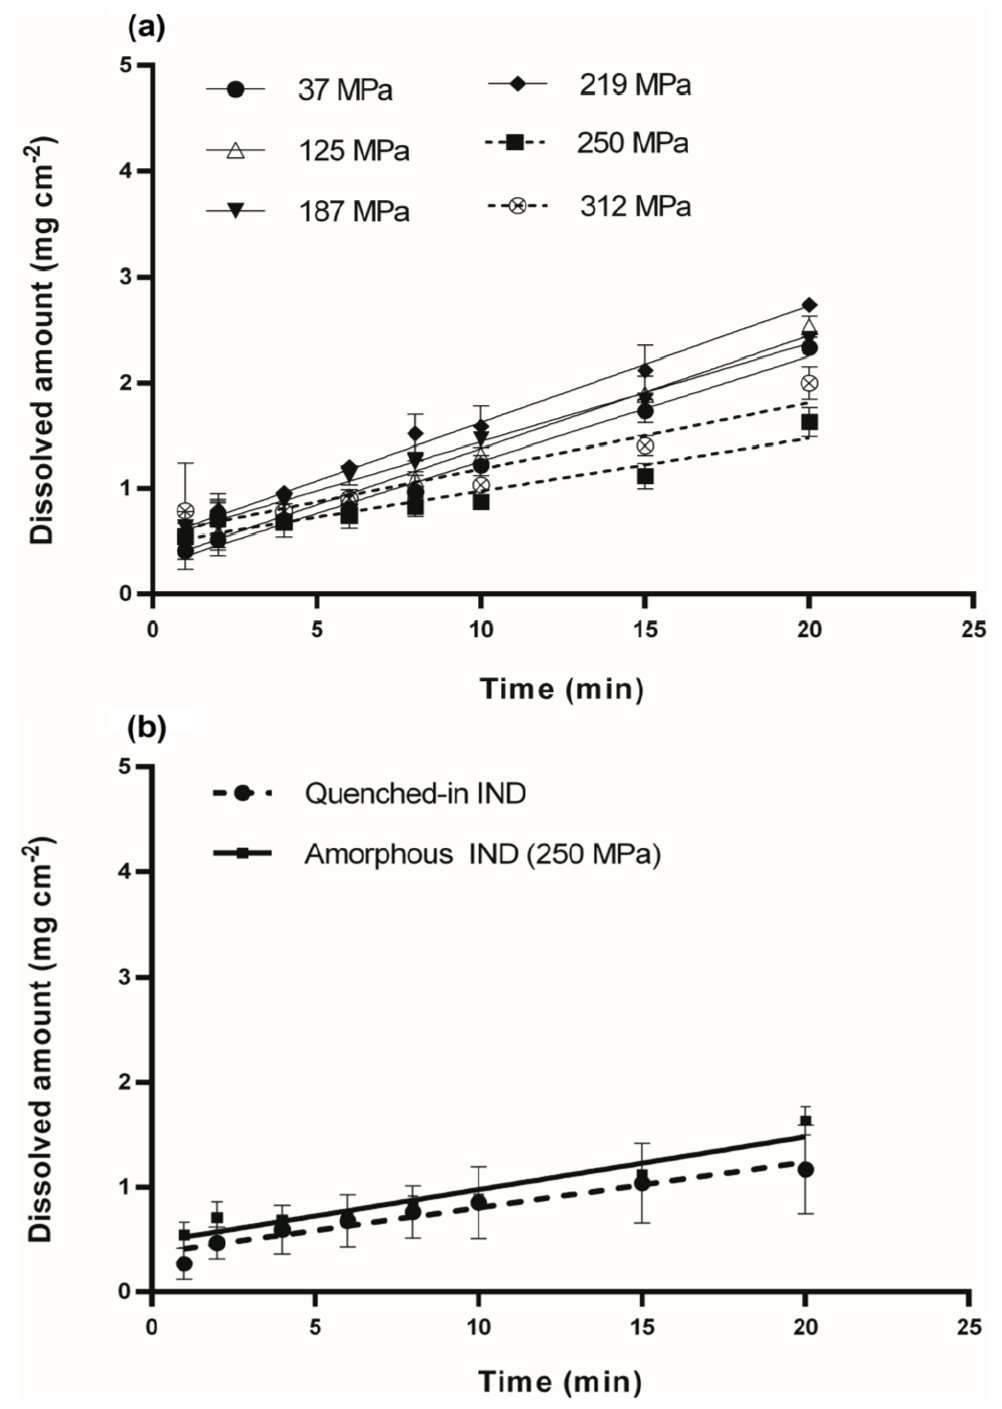
Figure 5. ( a ) Dissolution profiles of amorphous IND compacts, prepared by different compression pressure (37, 125, 187, 219, 250 and 312 MPa); ( b ) Dissolution profiles of quench-in IND discs and milled IND compacts compressed at 250 MPa (dissolution experiments were carried out at 37 ± 0.5 °C for 20